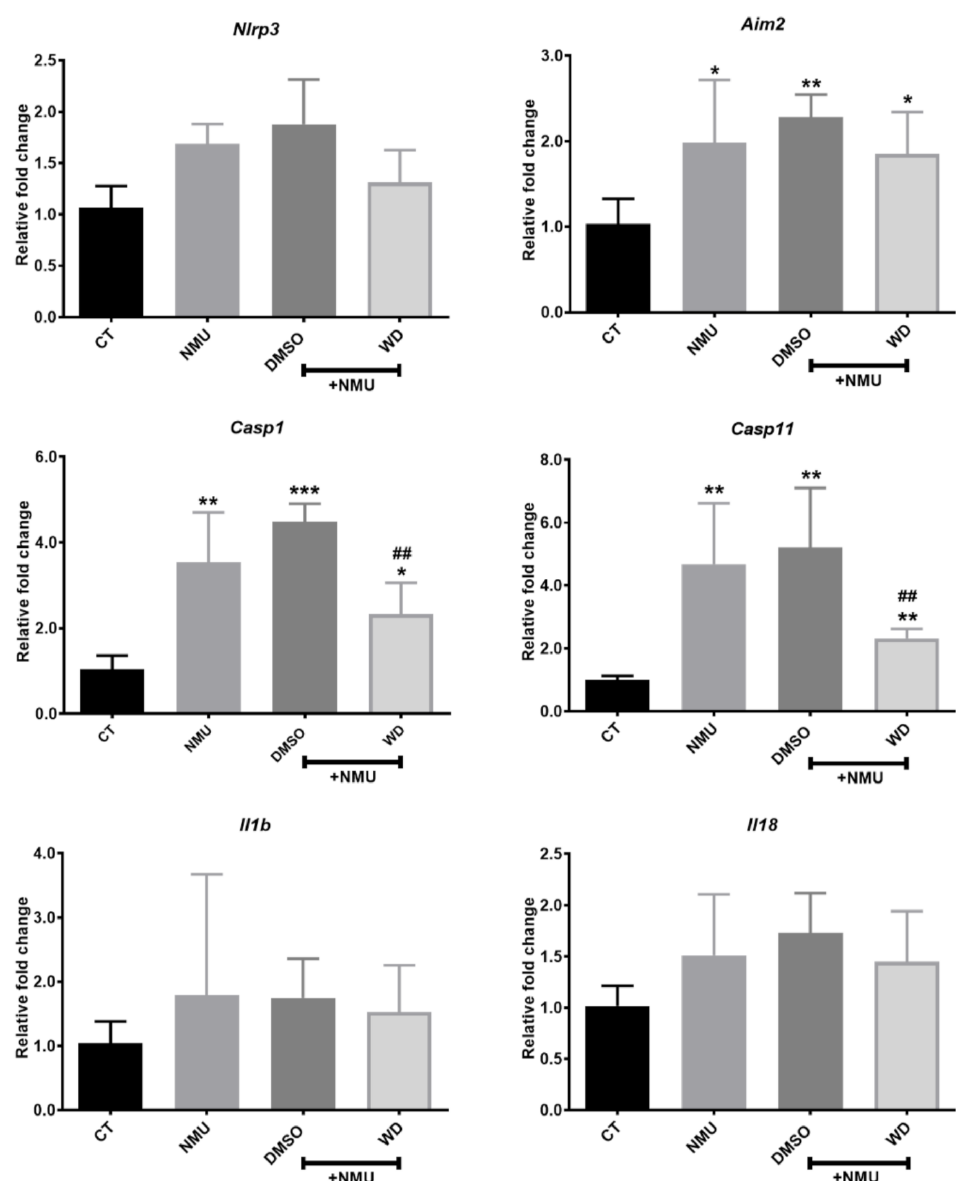
Figure 2. Three-month old mice were injected with NMU in combination with either WD or DMSO. After 7 days, the retinas were enucleated from mice and processed for mRNA expression of the inflammasome components. Relative mRNA expression of inflammasome components compared to the reference gene Rn18s. CT: n = 4, NMU: n = 6, NMU + DMSO: n = 6, NMU + WD: n = 6; n : the number of mouse eyes per group. One-way ANOVA with Tukey’s post-hoc test * p < 0.05, ** p < 0.01, and *** p < 0.001: comparison to CT. ## p < 0.01: comparison between NMU + WD and NMU + DMSO. One-way ANOVA with Tukey’s post-hoc test. Error bars shown as mean ±